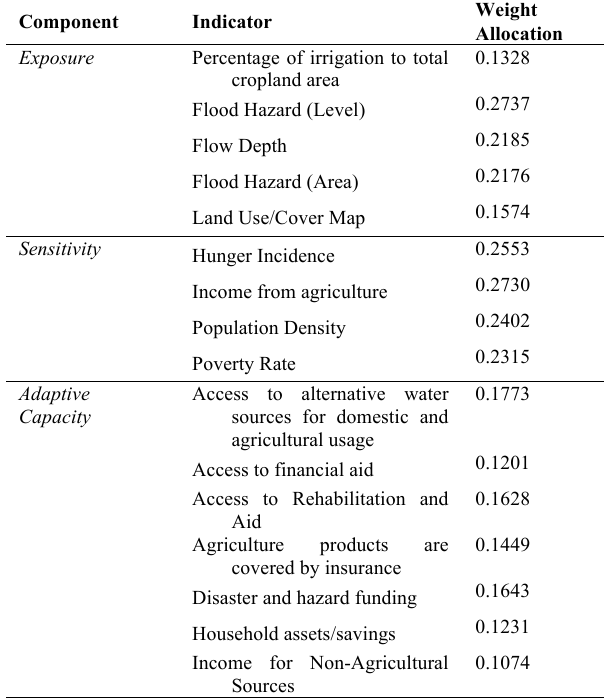
Table 2. Weights of each indicator derived from the results of